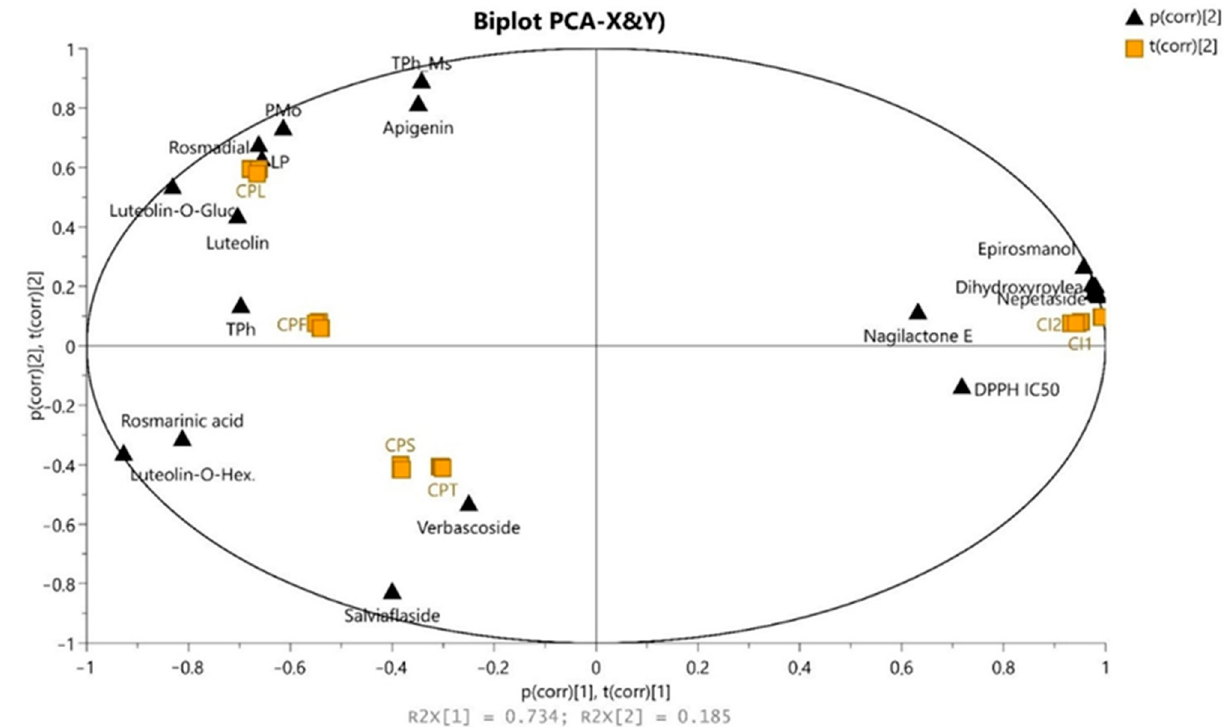
Figure 2. PCA biplot data showing correlation of C. amboinicus cultivated in Indonesia (CI1 and CI2) and leaves (CPL), flowers (CPF), stems (CPS) and twig (CPT) from Coleus amboinicus Lour. cultivated in Poland with their respective 95% confidence regions and antioxidant test.